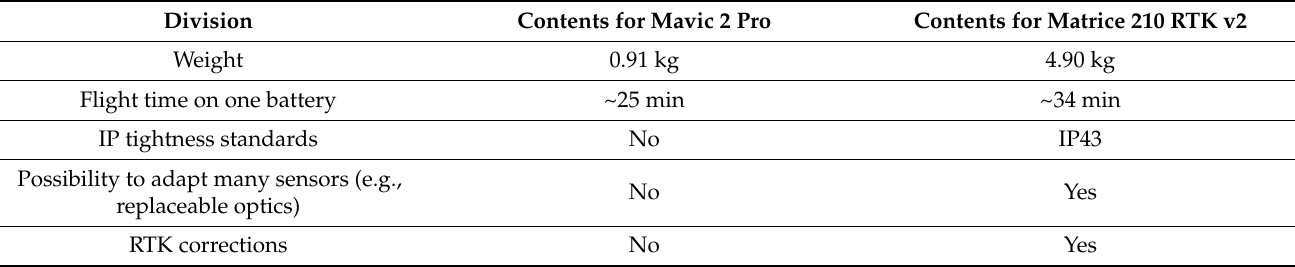
Table A1. Comparative characteristics of the UAVs used in this study.